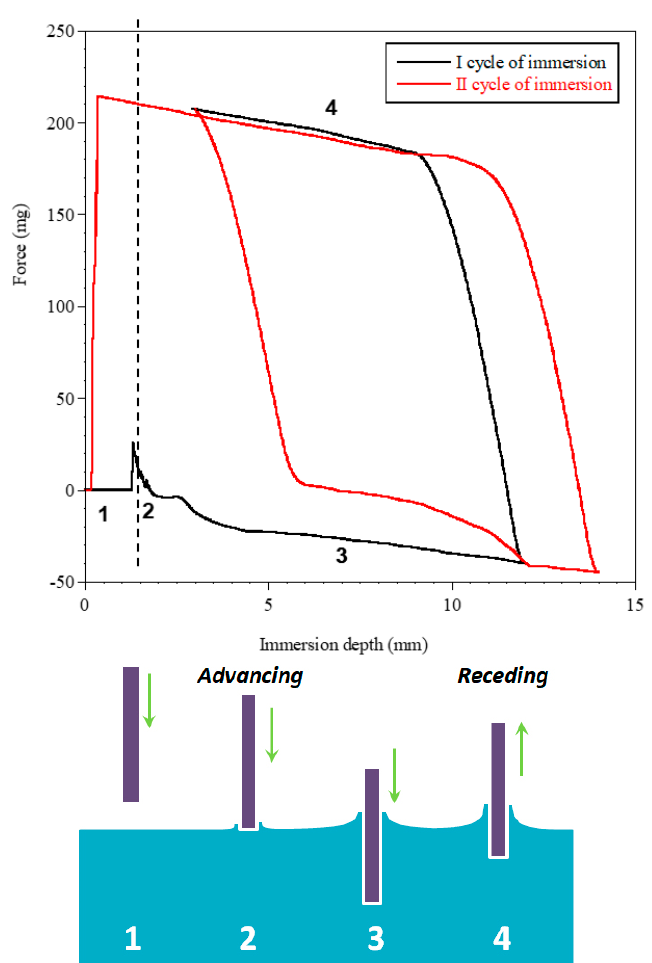
Figure 7. DCA cycles of immersion for PEUA-PEG 30 by using the Wilhelmy plate method. In the figure, numbers 1 to 4 indicate the position of the plate with respect to the liquid, as shown in the image below the figure. 1—Out of the liquid; 2—point of touch of the sample with the liquid; 3—Immersion into the liquid ( θ adv ); 4—Emersion from the liquid ( θ rec ). Table 2. Contact angle values ( θ adv and θ rec ) and hysteresis (H) for PEUA and PEUA-PEG 30 in the first and second cycles of immersion.